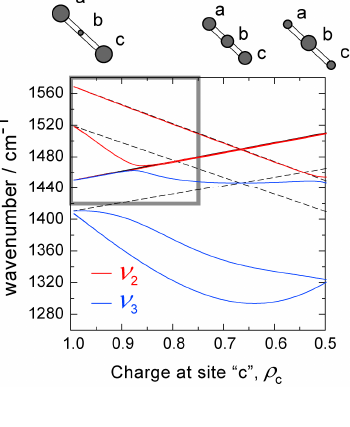
Figure 6. Behavior of the ν modes in a linear trimer as a function of the fractional charge, 3 ρ . The frequencies of the ν modes are also shown in this figure. Transfer integrals, on-site 2 Coulomb energy and nearest neighbor Coulomb energy are assumed to be 300 meV, 0.8 eV and 0.2 eV, respectively. The frequencies of the unperturbed conditions are based on reference [17]. Avoided crossing is expected to be occurring for large ρ enclosed by the